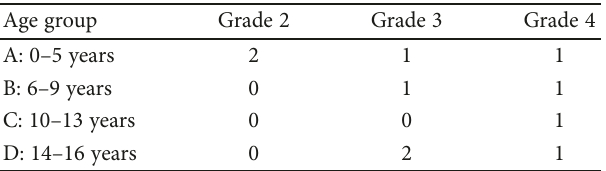
Table 7: Osteoarthritis grade evaluated by the vets prior to CAD- MSC treatment for dogs receiving both IA and IV injections.